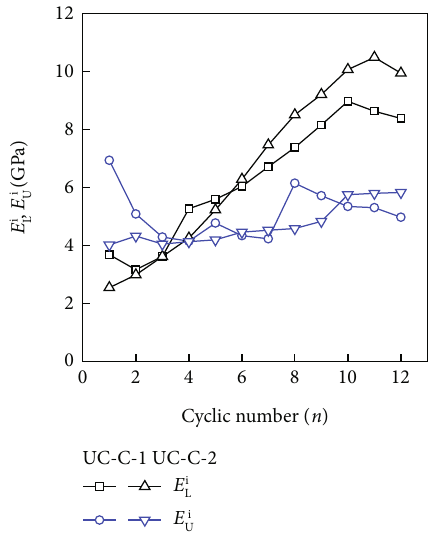
Figure 6: Loading and unloading moduli of sandstone under cyclic